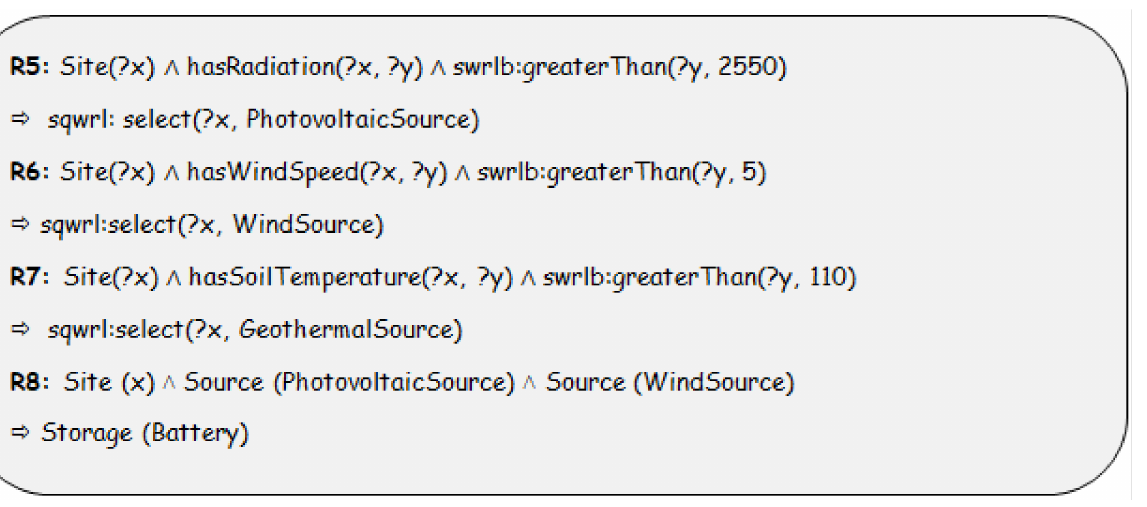
Figure 6. Examples of intelligent reasoning